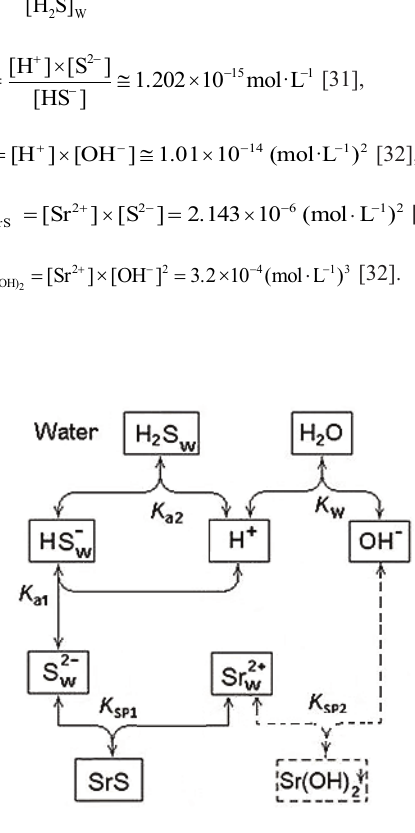
Fig. 1. Structural scheme demonstrating the distribution of ions and molecules in the closed equilibrium system of H 2 O−SrS, where K a1 is the first acid dissociation constant of H 2 S, K a2 the second acid dissociation constant of H 2 S, K W the ion­product constant of water, K SP1 the solubility product constant of SrS, and K SP2 the solubility product constant of Sr(OH) 2